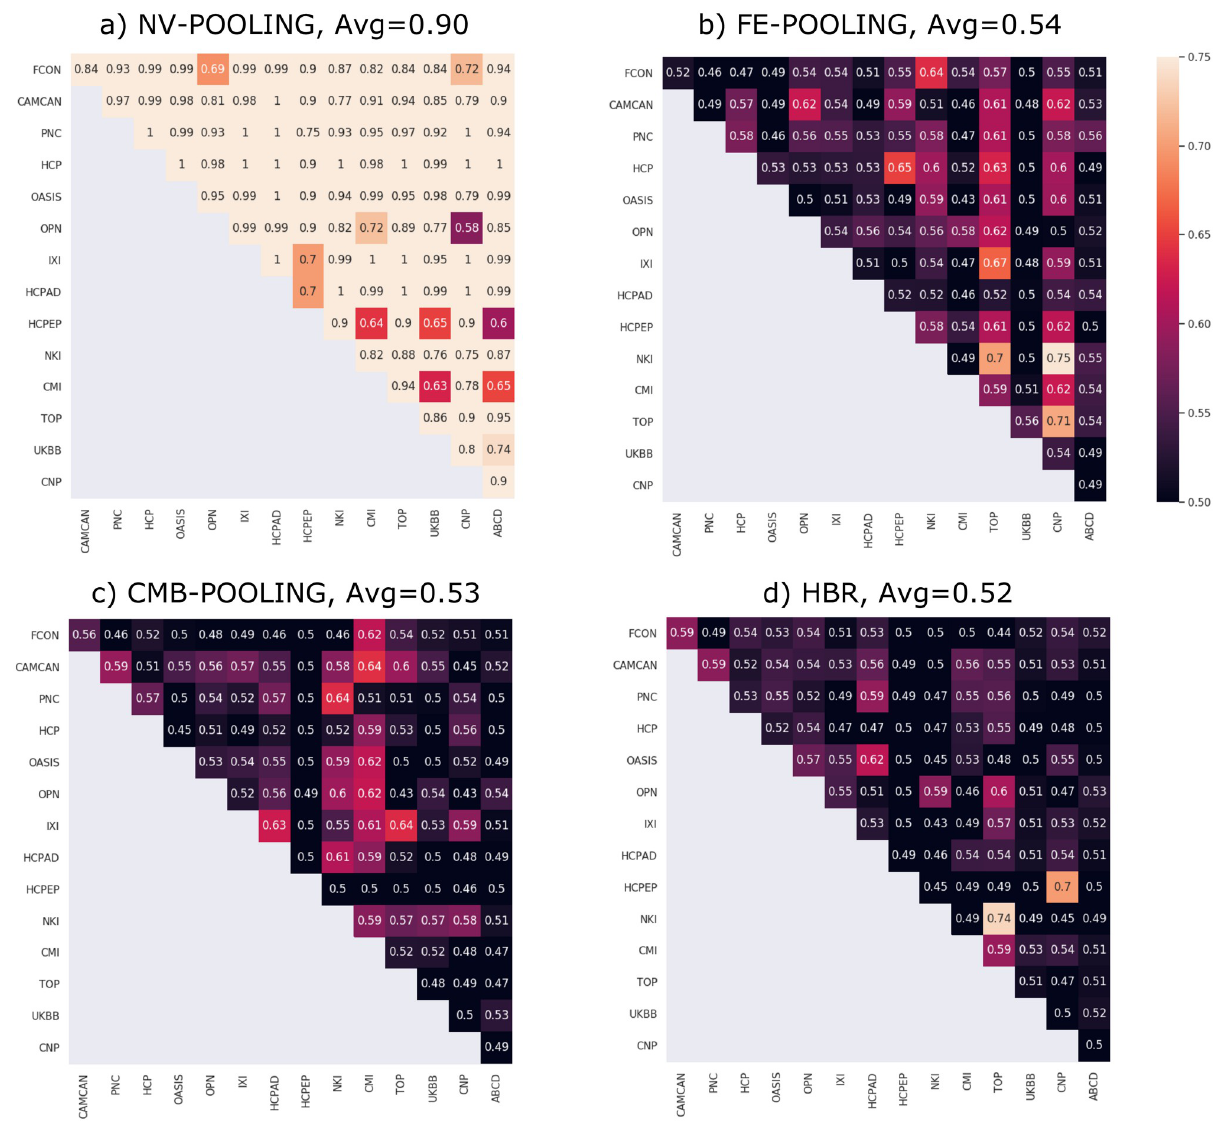
Fig 8. Balanced-accuracies in classifying z-statistics across different datasets in a one-vs-one scenario. The z-statistics are computed using different modeling approaches including naive pooling (NV-POOLING), fixed-effect pooling (FE-POOLING), pooling after ComBat harmonization (CMB-POOLING) and HBR. The results show that the site-effects are to high degree not present in the z-statistics in FE-POOLING, CMB-POOLING, and